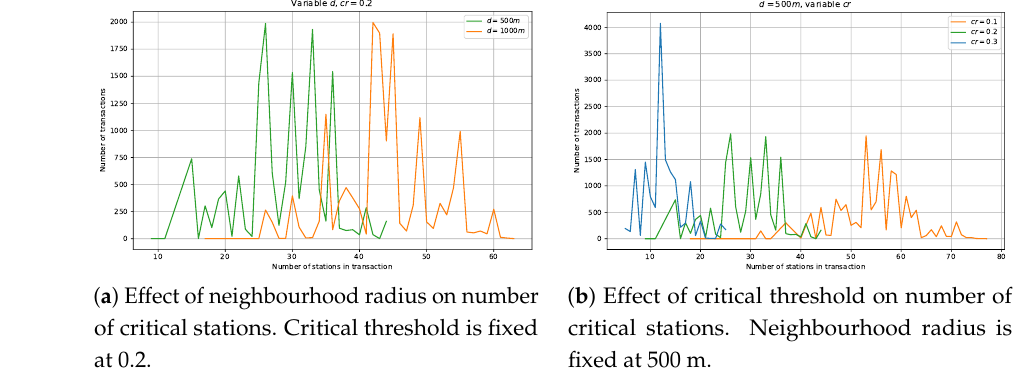
Figure 5. Number of critical stations with varying d and cr .